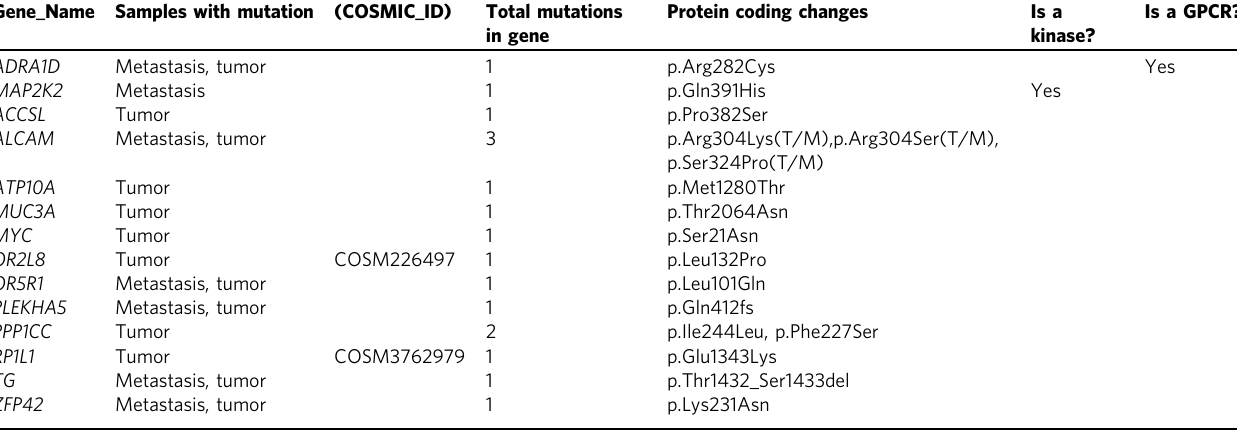
Table 1 Table listing the somatic mutations detected for the tumor and LN metastasis. Gene_Name Samples with mutation